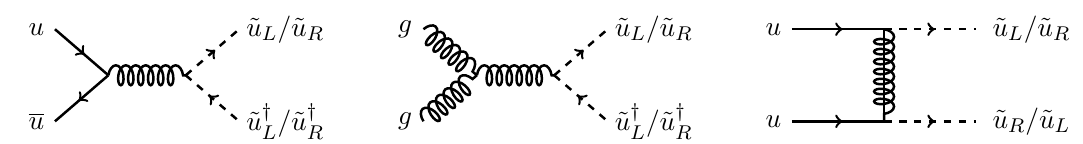
Figure 1 . Examples of tree-level diagrams for squark pair production in the MRSSM. In contrast to the MSSM, R-symmetry forbids ~ u L ~ u L or ~ u L ~ u y (s)quark (cid:13)avour is